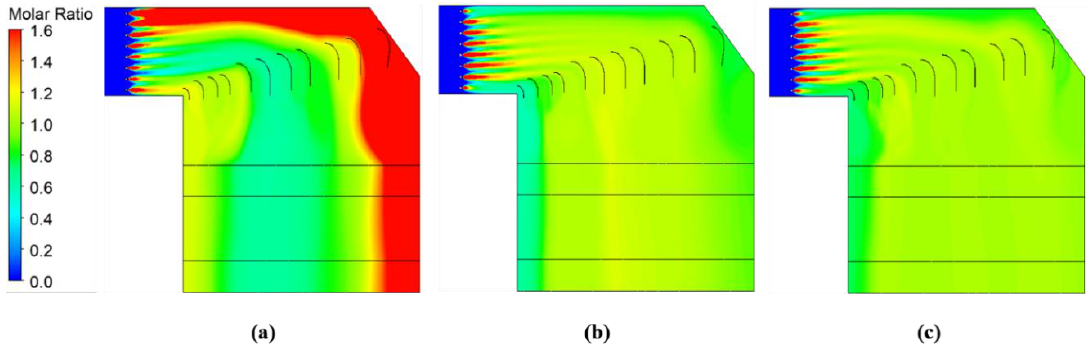
Figure 18. Distribution of NH 3 /NO around the flow passage for the lower-skewed profile. ( a ) Constant injection; ( b ) adjusted injection; ( c ) optimized injection.